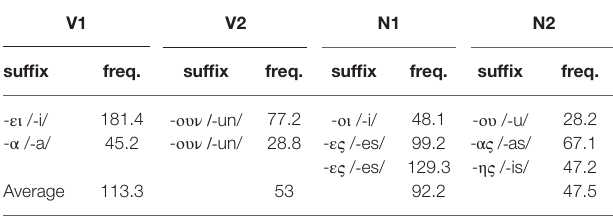
TABLE 1 | Suffixes used in Experiments 1–4 and their frequencies.